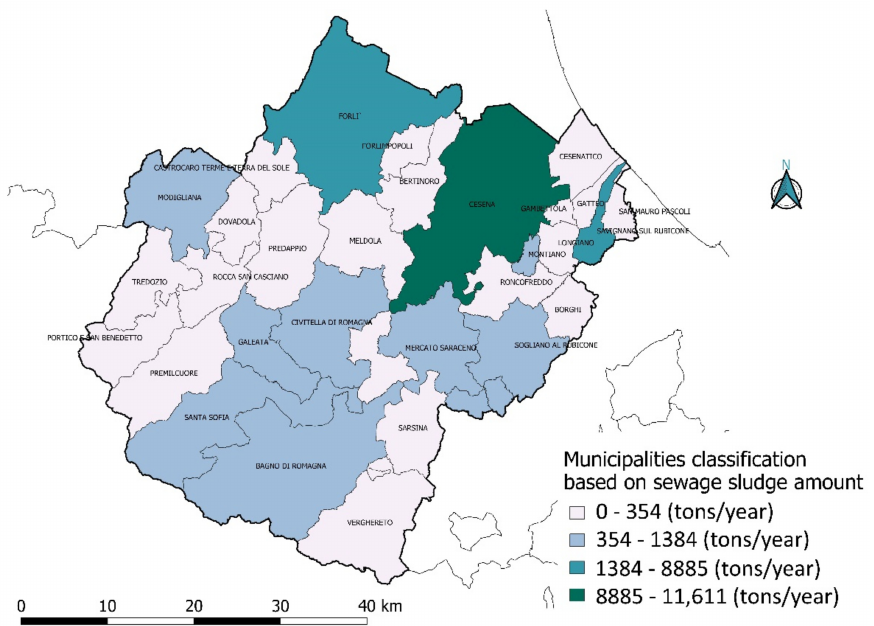
Figure 5. Forl ì -Cesena’s municipalities classification based on the amount of processed sewage sludge at the territorial level.